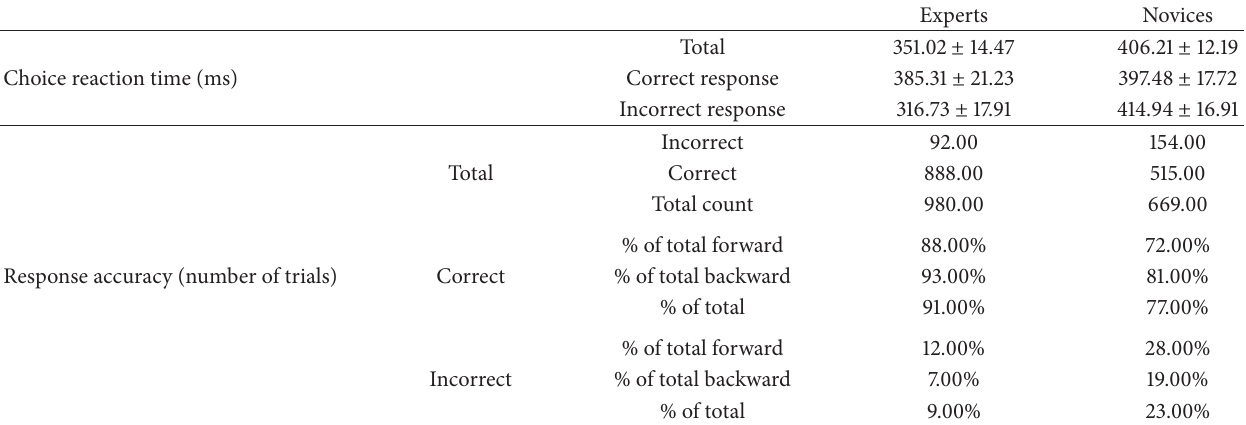
Table 1: Dependent measures, choice response time (CRT) and response accuracy (RA), recorded on the anticipation test across groups (mean ± s ). Only trials with response time between 150 and 600 msec are